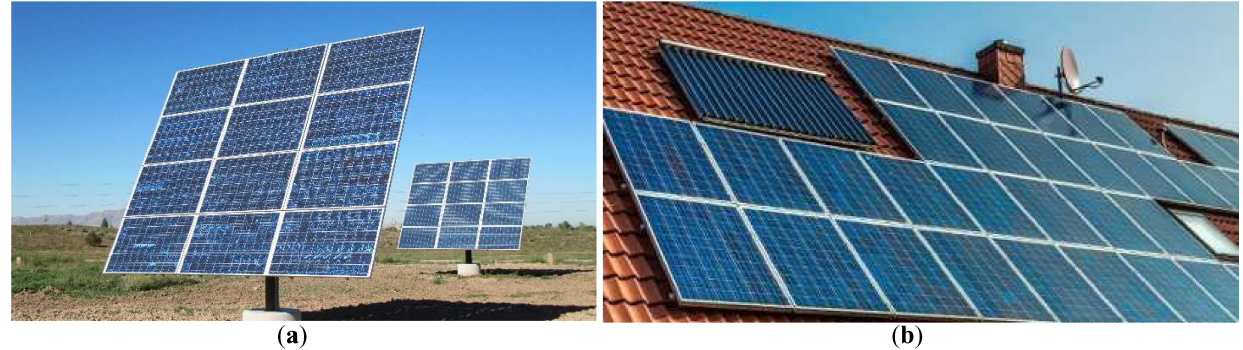
Figure 1. Examples of different types of solar installations. ( a ) Free standing solar panel, equipped with a solar tracker and actuators, enabling the tracking of sun position throughout the days and seasons 17 . ( b ) Roof-mounted solar panel with a fixed mount and no ability to track the